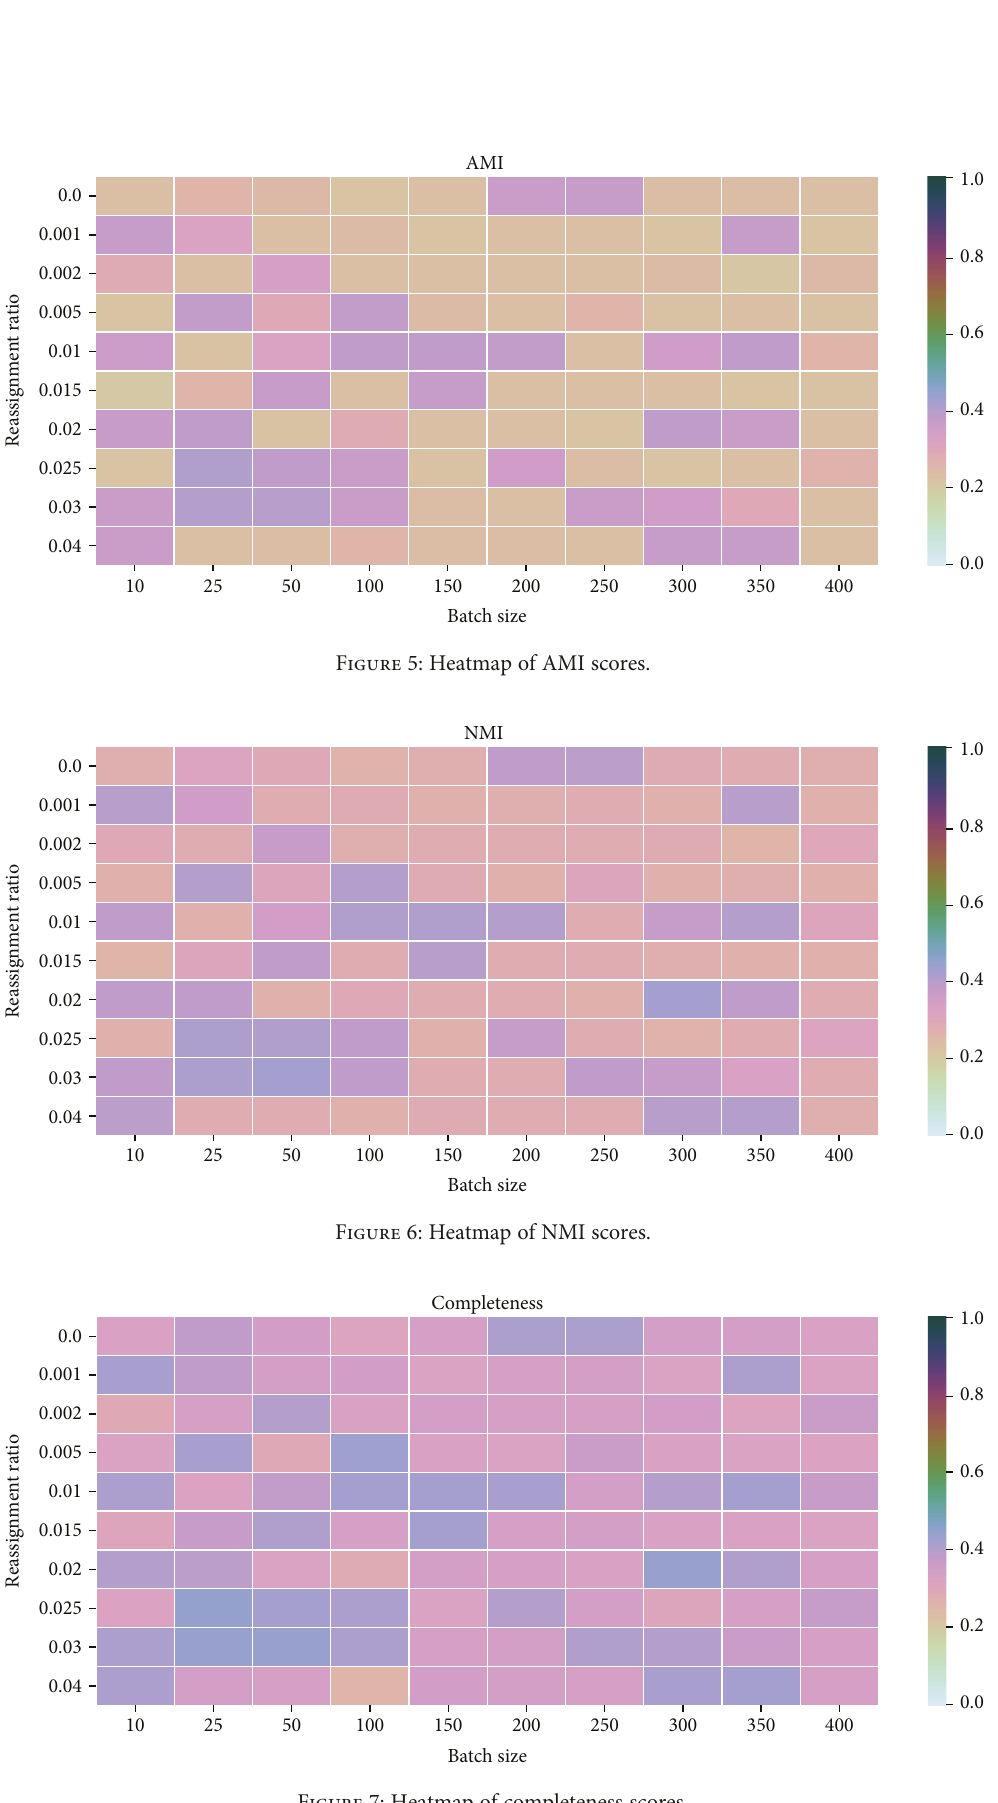
Figure 7: Heatmap of completeness